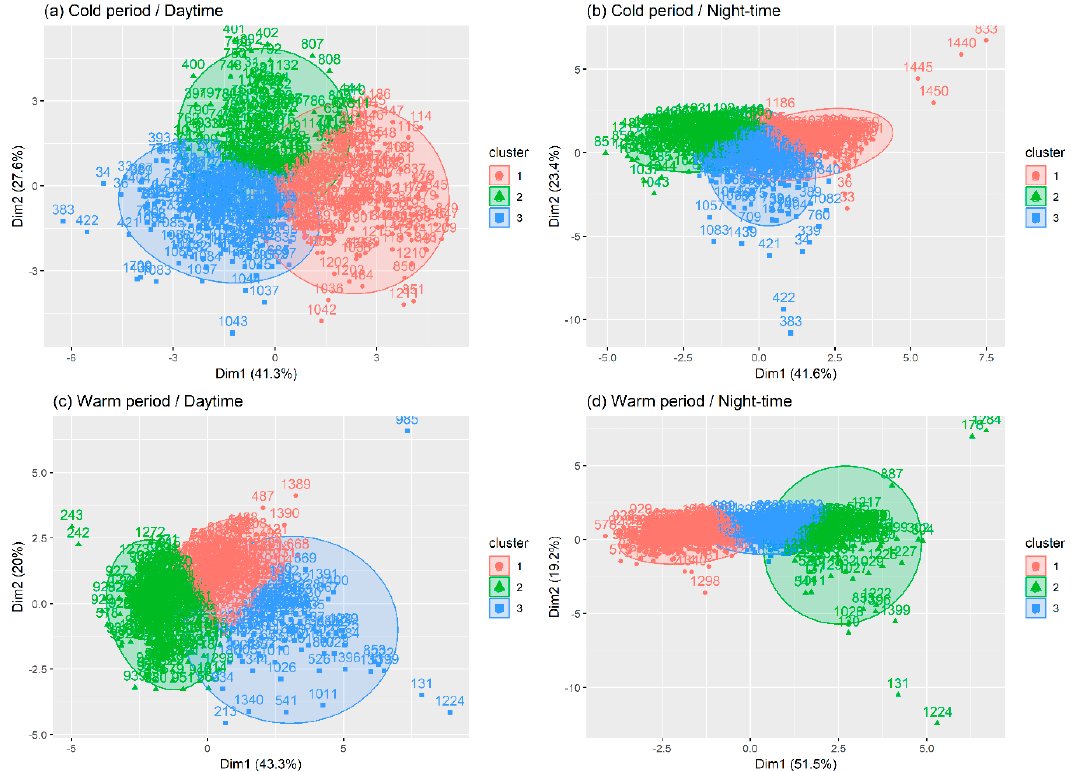
Figure 3. Cluster analysis of daytime and night-time data for the cold and warm periods at the suburban station. Table 4. Mean values of investigated parameters for day-time data of the suburban station for the clusters of cold period (three clusters) and warm period (three